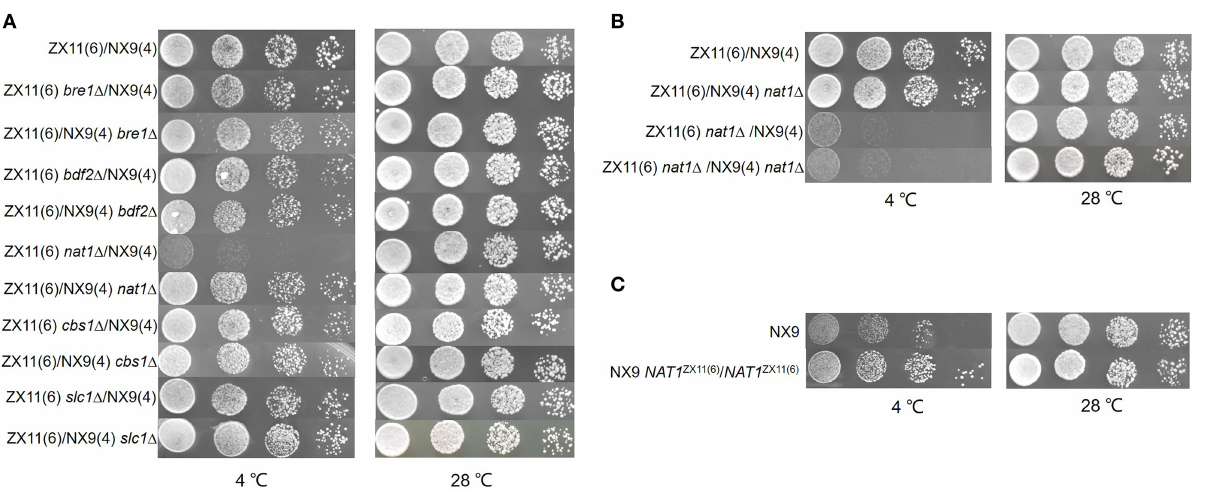
FIGURE 7 | Identification of the causative gene NAT1 . (A) RHA results of the five selected genes. Spot growth assay on the hemizygous diploids for BRE1 , BDF2 , NAT1 , CBS1, and SLC1 were shown. The reciprocal hemizygote containing the ZX11(6) allele grew better than the one presenting the allele of NX9(4) at 4 ◦ C. (B) Effect of NAT1 deletion on near-freezing temperature tolerance. The NAT1 was deleted in the hybrid diploid ZX11(6)/NX9(4) background. ZX11(6) nat1 1 /NX9(4) nat1 1 showed the same growth as ZX11(6) nat1 1 /NX9(4) at 4 ◦ C and ZX11(6)/NX9(4) nat1 1 showed the same growth as ZX11(6)/NX9(4) at 4 ◦ C. (C) NAT1 allele replacement in strain NX9. The both NAT1 alleles in the original sensitive parent strain (NX9) was replaced by the NAT1 ZX11(6) alleles. Allelic exchange of NAT1 ZX11(6) led to a remarkable positive impact on the growth at 4 ◦ C.